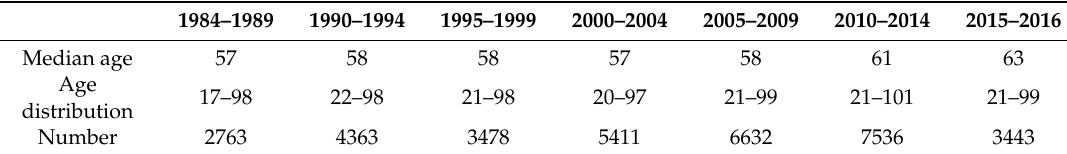
Table 1. Median age for malignant neoplasm of breast cases in 1984–2016.